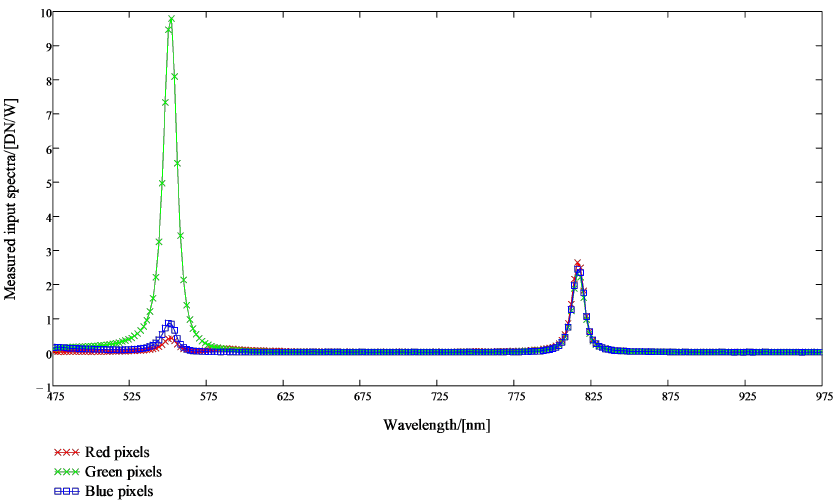
Figure 9. Results of the SICSURFIS HSI monochromator calibration. The scaled R-, G- and B-pixel sensitivity signals are plotted in units DN/(W/nm). There are two peak wavelengths for the selected PFPI drive voltage, 548.2 nm (on the left) and 812.2 nm (on the